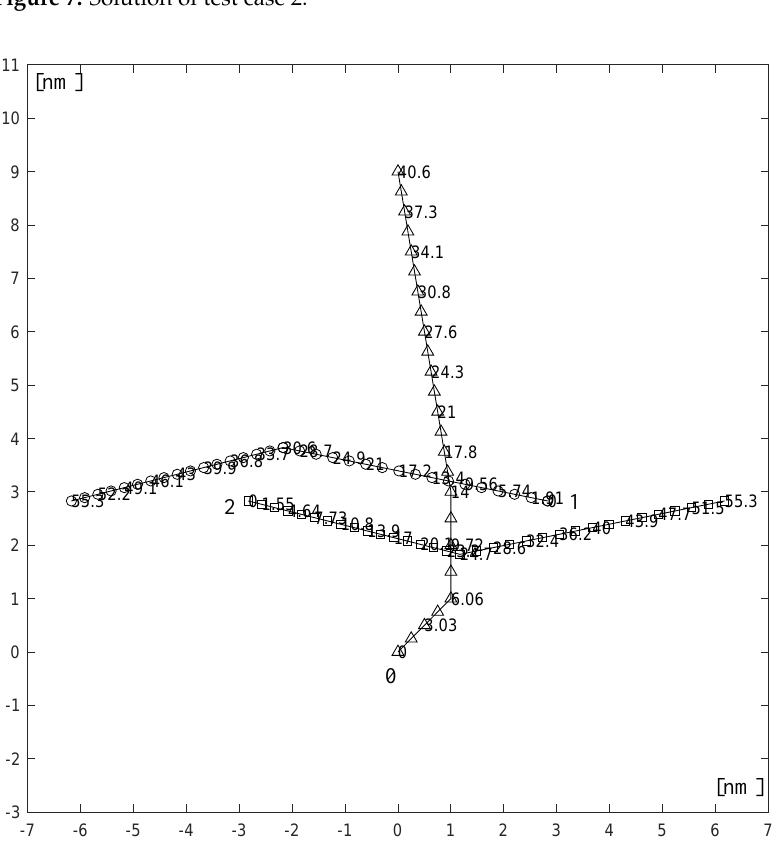
Figure 8. Solution of test case